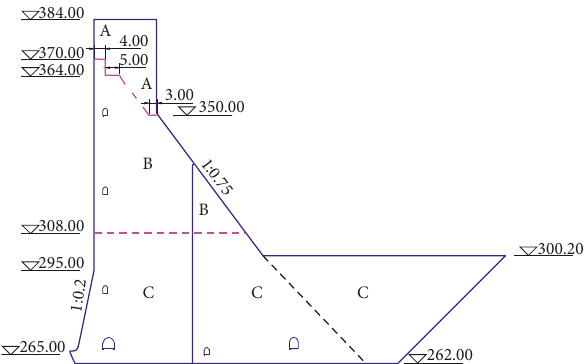
Figure 3: Material zoning of the dam Table 1: The dam body material zoning information.